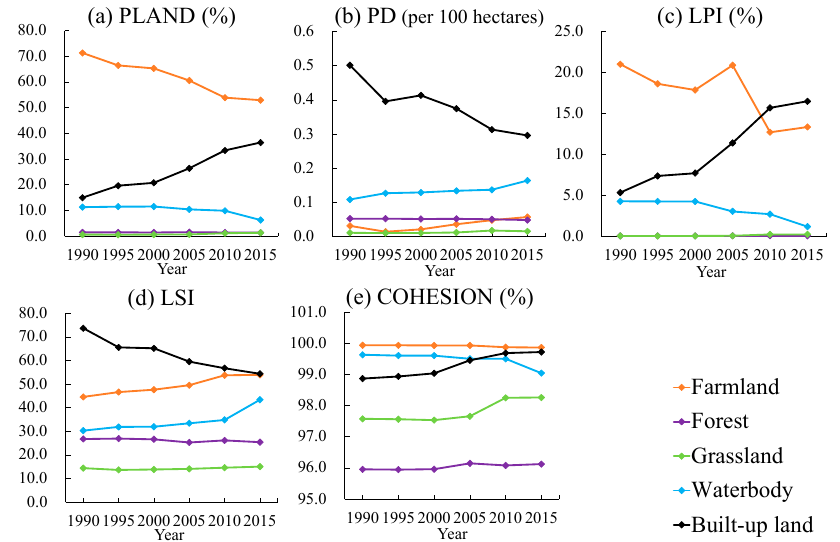
Figure 10. The class-level metrics of green space and built-up area from 1990 to 2015. ( a ) PLAND of green space and built-up area from 1990 to 2015; ( b ) PD of green space and built-up area from 1990 to 2015; ( c ) PLAND of green space and built-up area from 1990 to 2015; ( d ) LSI of green space and built-up area from 1990 to 2015; ( e ) COHESION of green space and built-up area from 1990 to 2015.